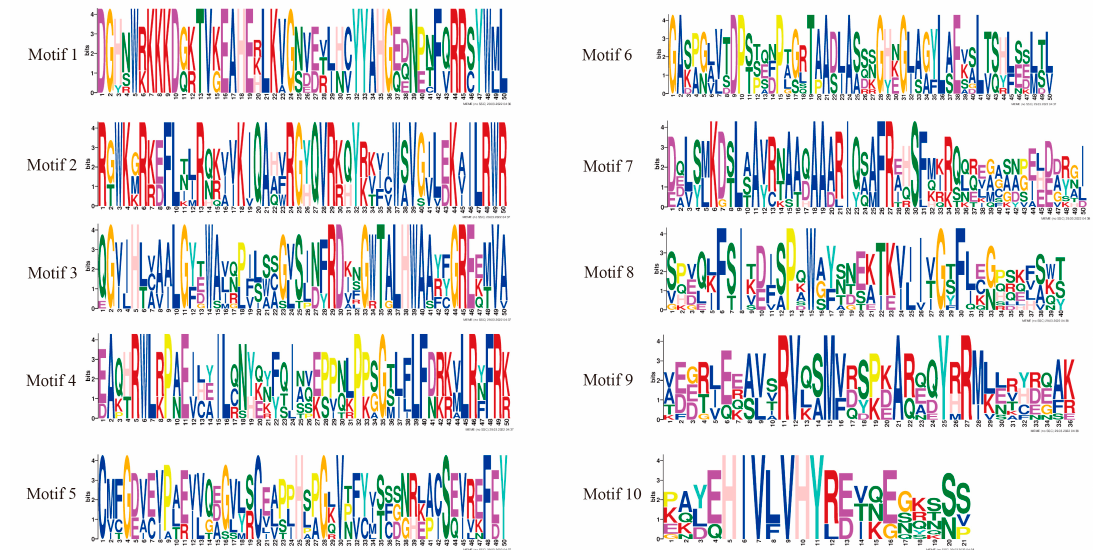
Figure 3. Sequence logo of all identified motifs of HmCAMTA. Motifs 1~10 represent different conservative amino acid sequences, and the fewer amino acids that appear at different positions in each motif, the more conserved it is.